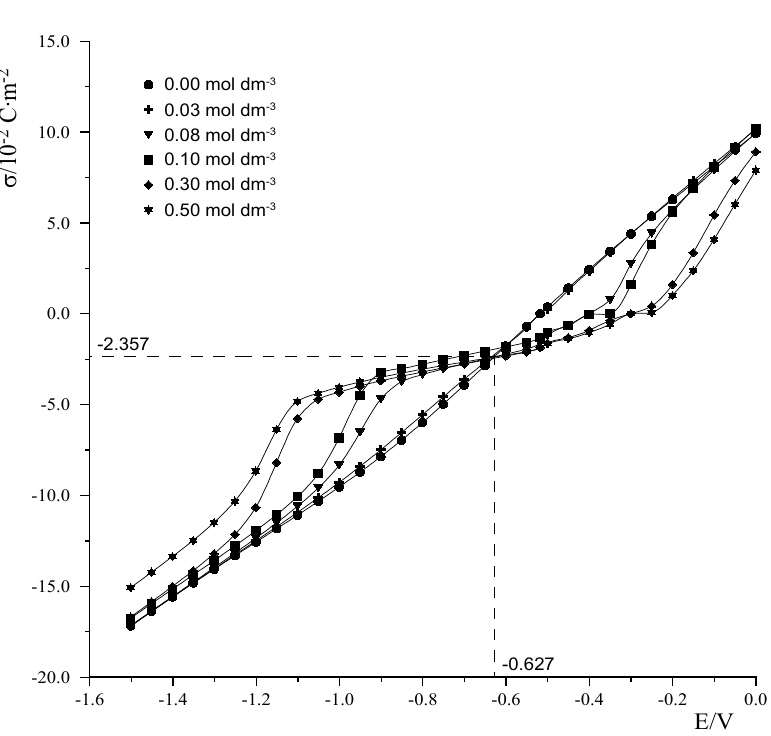
Figure 2. S urface charge of the electrode vs. its potential for various concentrations of tert-butanol in 4 mol dm -3 NaClO